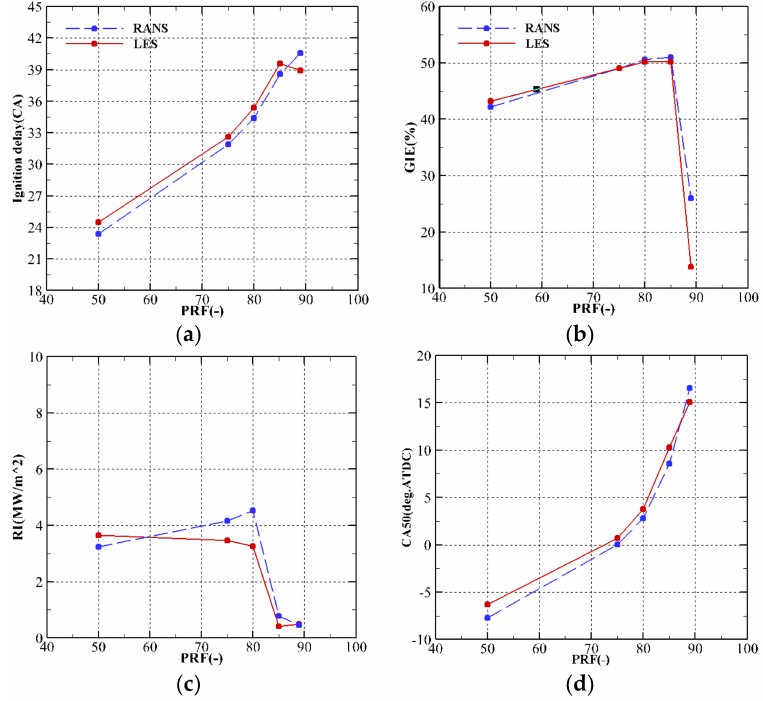
Figure 5. Comparison of LES and RANS model for: ( a ) ignition delay (ID), ( b ) gross indicated efficiency (GIE), ( c ) ringing intensity (RI) and ( d ) CA50 variations over natural gas mass fractions